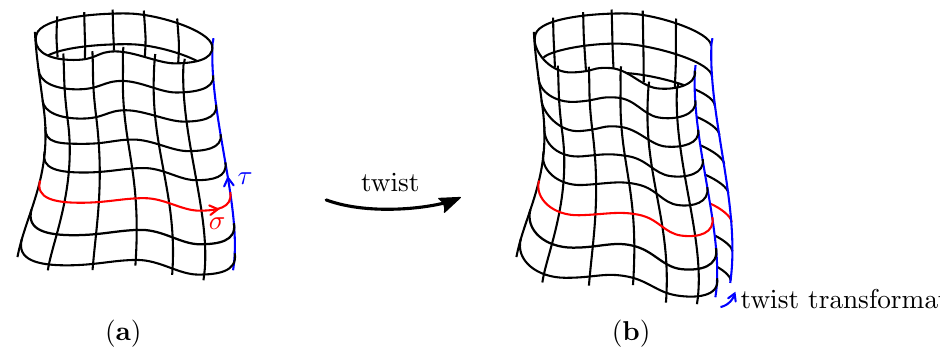
Figure 6 . ( a ) A closed string in AdS 5 (cid:2) S 5 that is dual to a single-trace operator in the boundary N = 4 SYM theory. ( b ) After twisting of the single-trace operator, the dual string is no longer closed. Instead, it is described by a map from the worldsheet to AdS 5 (cid:2) S 5 that is not single valued. As we go around the worldsheet, we end at two di(cid:11)erent points in spacetime that are related to each other by the twist isometry